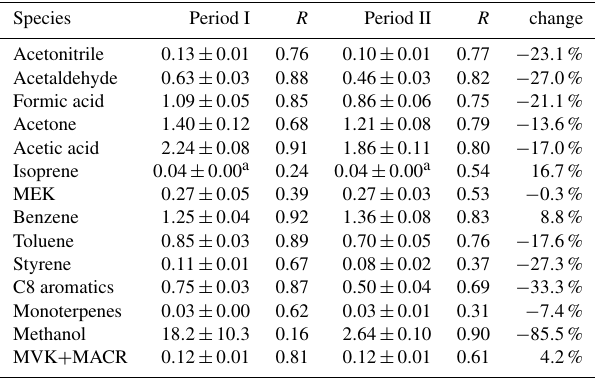
Table 3. Comparison of ERs of the urban site during different peri- ods.